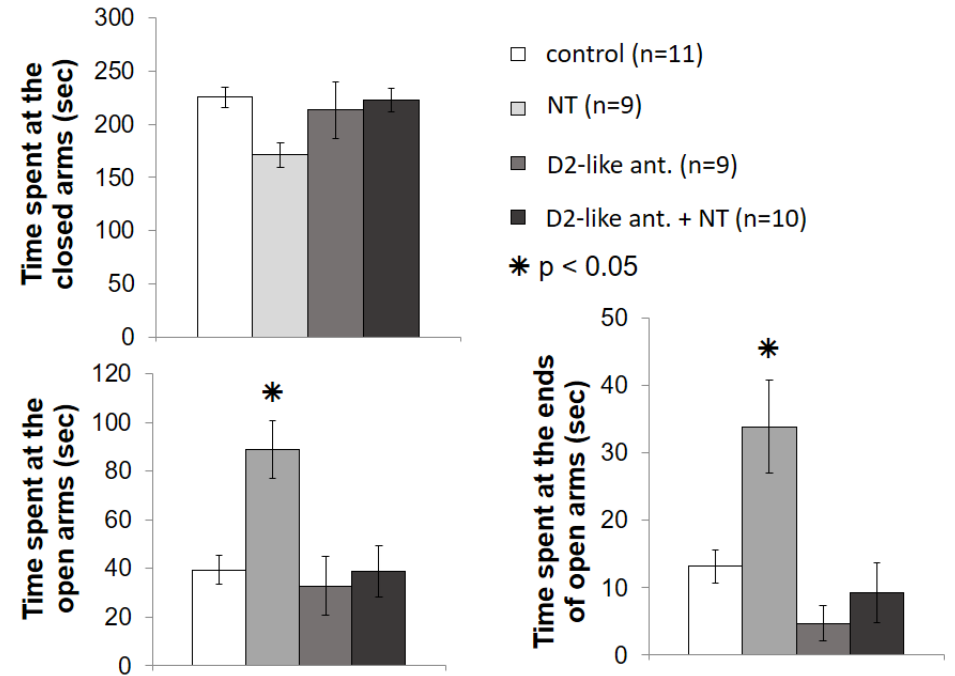
Figure 5. Effects of D2-like DA receptor antagonist sulpiride pretreatment on the anxiolytic effect of NT in the VP in EPM test. Columns represent mean time spent at the closed arms, time spent at the open arms, and time spent at the ends of the open arms, respectively (±S.E.M.). Control group: rats received two microinjections of vehicle (n = 11). NT group: animals microinjected with vehicle + 100 ng NT (n = 9). D2-like ant. group: animals received 4 μ g D2-like DA receptor antagonist sulpiride + vehicle (n = 9). D2-like ant. + NT group: effect of microinjections of 100 ng NT after 4 µ g sulpiride pretreatment (n = 10). For further explanation, refer to the text. *: p <